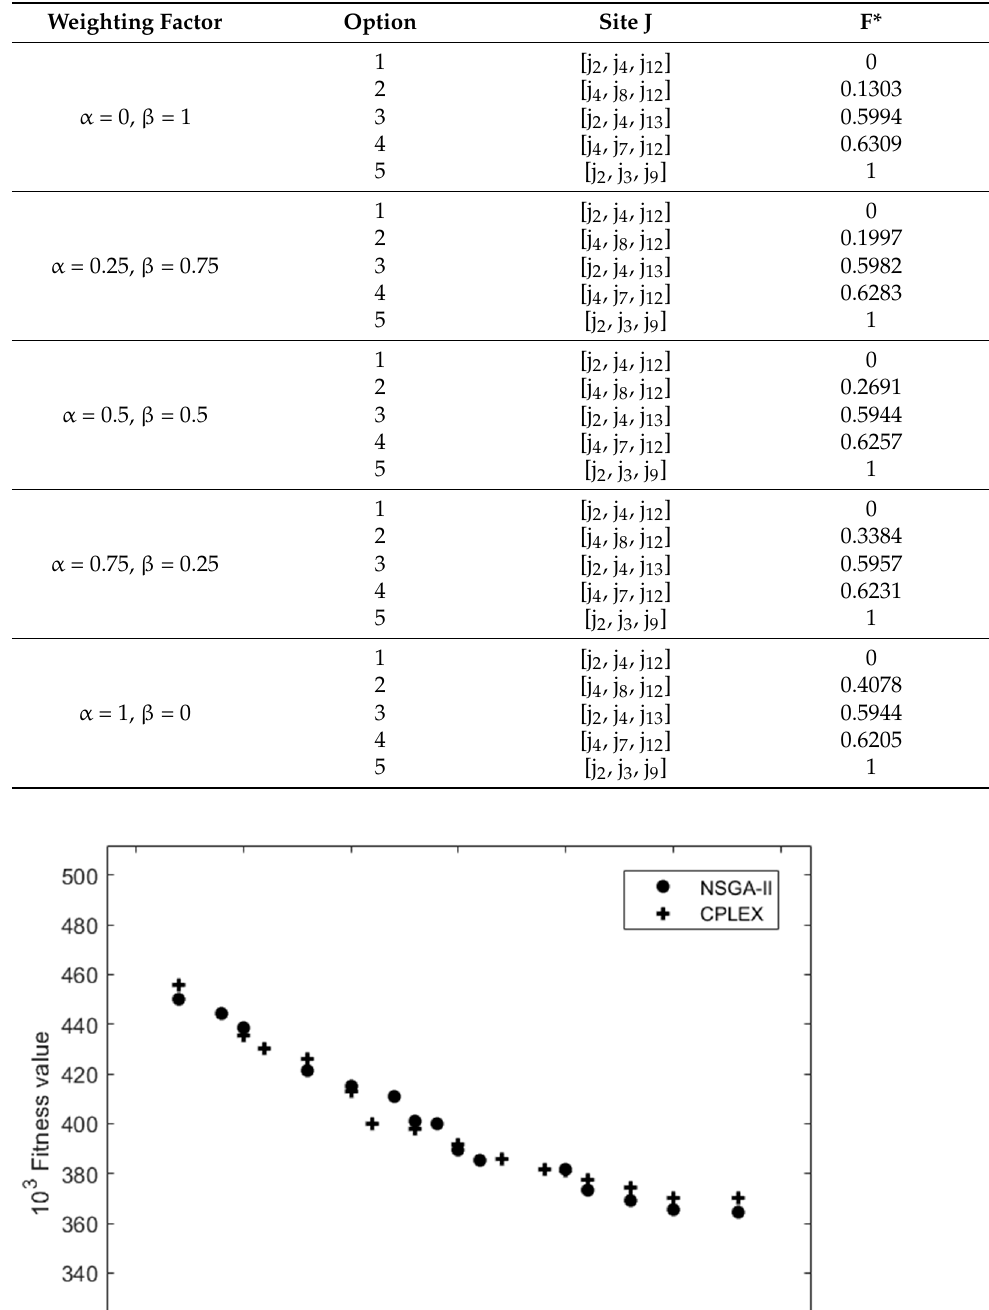
Table 7. Pareto optimal solution weighted results.